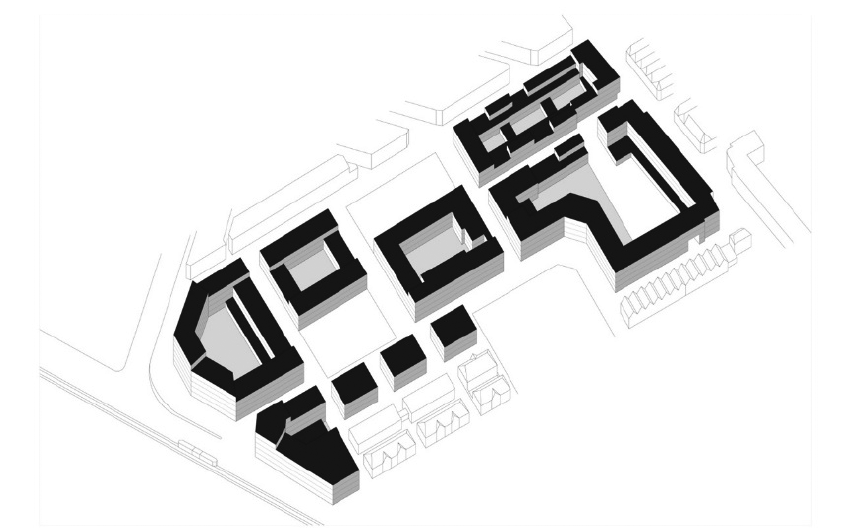
Figure 4. Deelgebied 5 (Schilderswijk, The Hague). The plan proposed by the Service of Urban Design ( Dienst Stadsontwikkeling [DSO]) of the Municipality of The Hague, 1984. Author’s